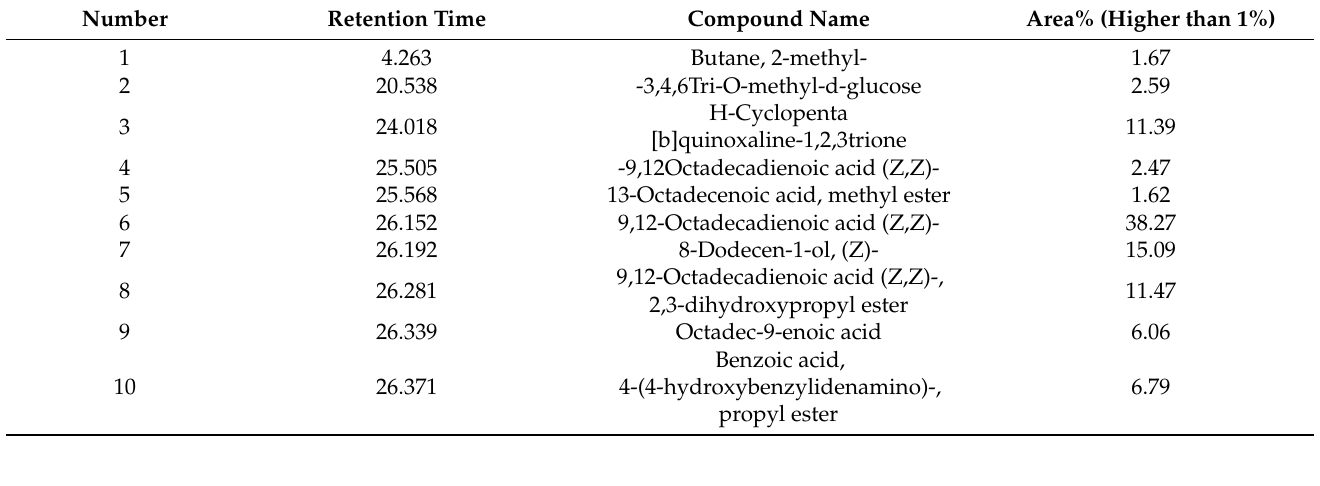
Table 2. Chemical groups and compounds present in the B . aegyptiaca seed aqueous extract.